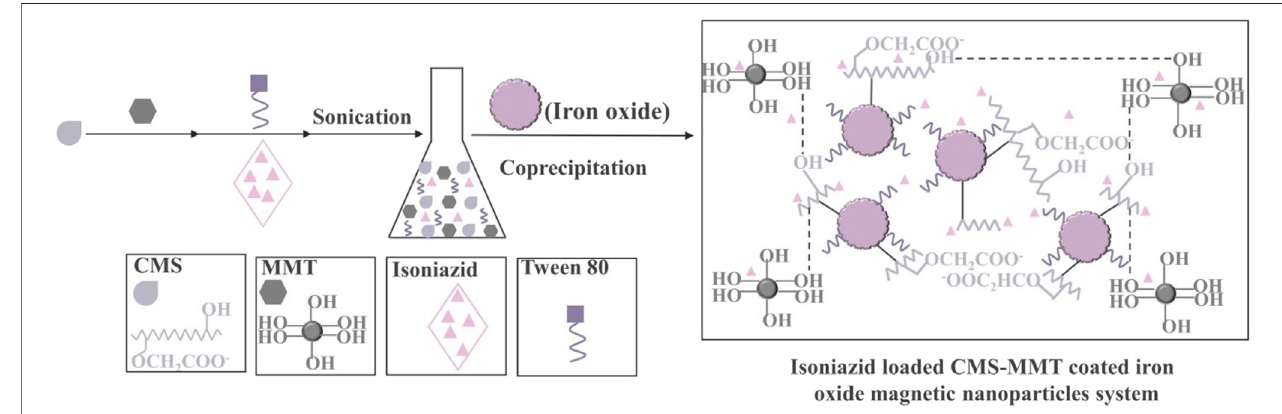
FIGURE 4 | Schematic representation of the preparation of isoniazid-loaded CMS-coated iron oxide/MMT nanoparticles (Saikia et al., 2015).